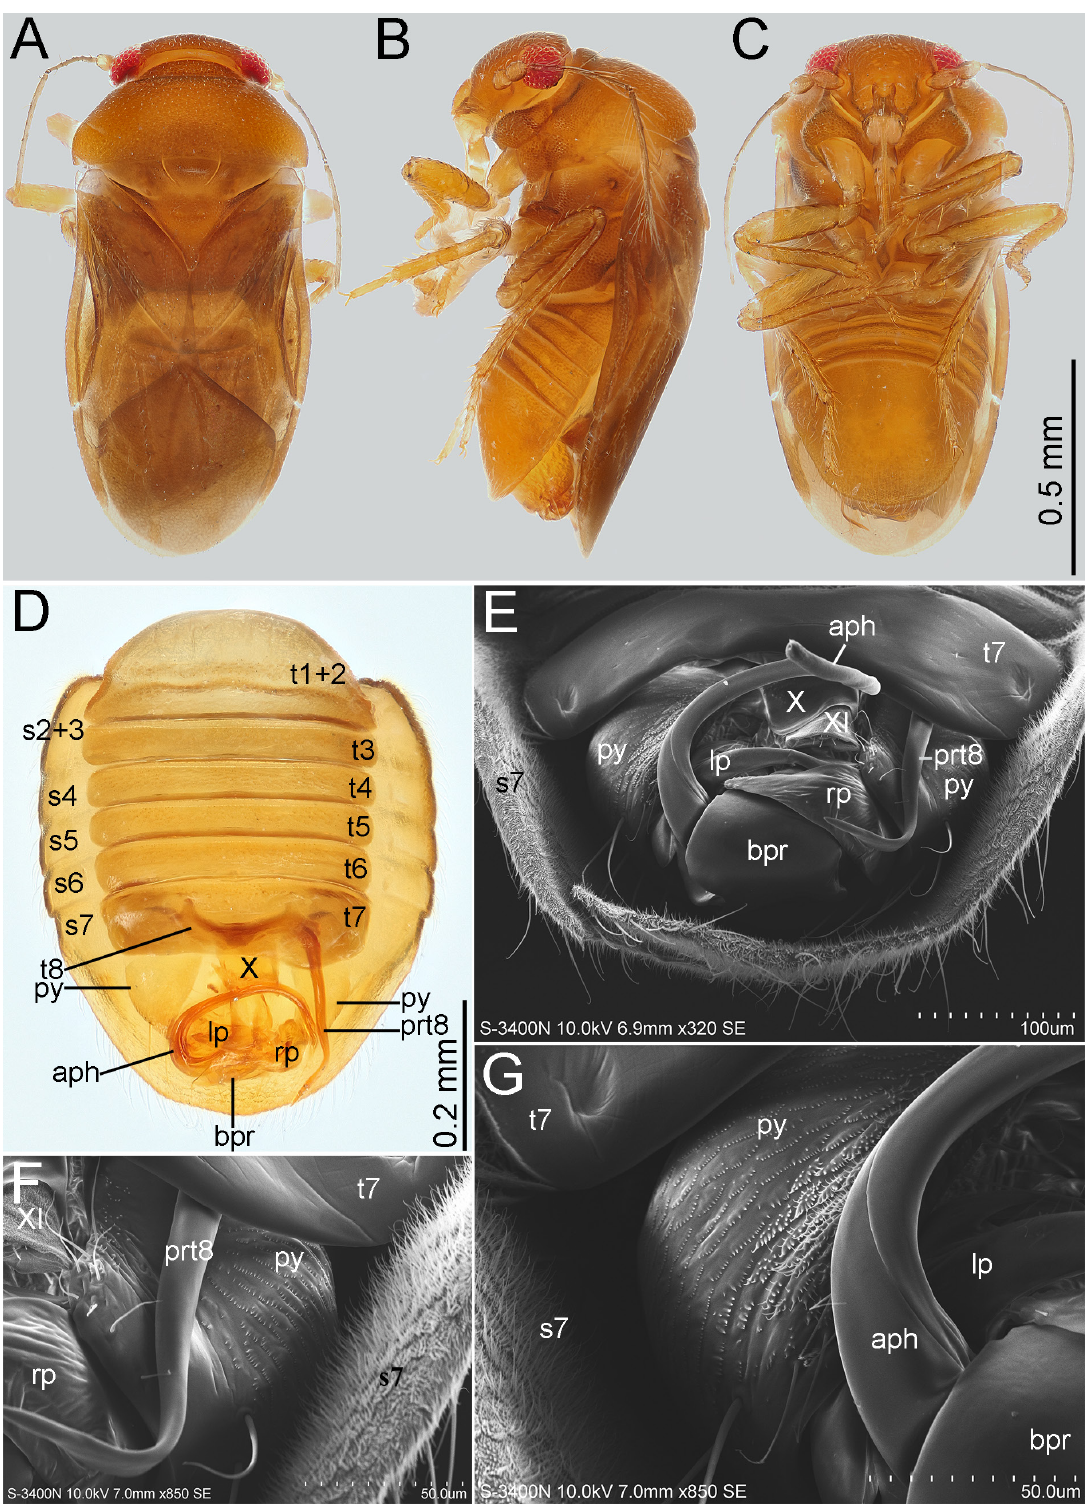
Fig. 1. Kokeshia acutiformis sp. nov. A‒C . Habitus, holotype, ♂ (SYSBM). A . Dorsal view. B . Lateral view. C . Ventral view. D . Pregenital abdomen and genitalia, dorsal view, paratype, ♂ (SYSBM). E‒G . Scanning electron micrographs of genitalia, paratype, ♂ (SYSBM). E . Dorsal view. F . Right side, dorsal view. G . Left side, dorsal view. Abbreviations: see Material and